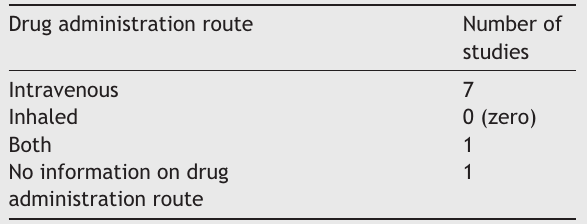
AG antibiotic administration route observed in